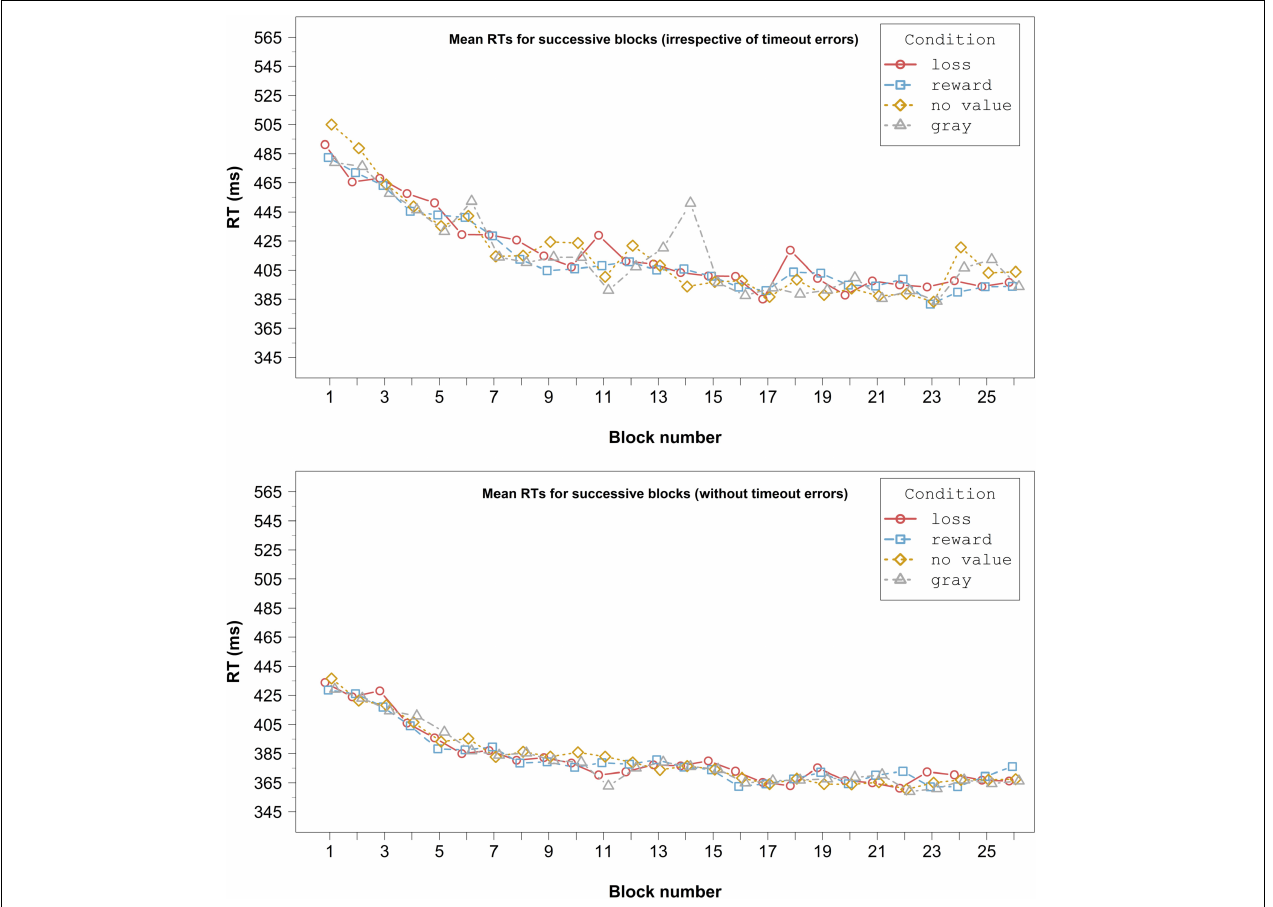
FIGURE 4 | RTs averaged across congruent and incongruent conditions for successive blocks in Experiment 2. The graph in the upper panel shows the complete data, irrespective of timeout errors. The graph in the lower panel displays only data, where the deadline was met. For clarity, error bars are not